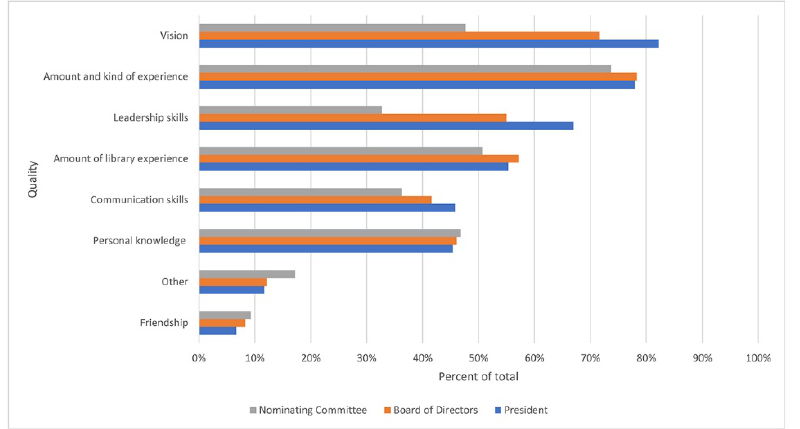
Figure 1 Desired qualities of candidates for Medical Library Association (MLA) national